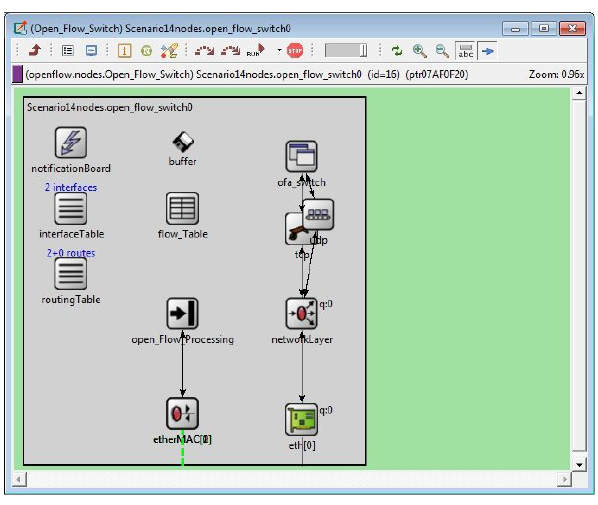
Figure 7. Module of class ofSwitch